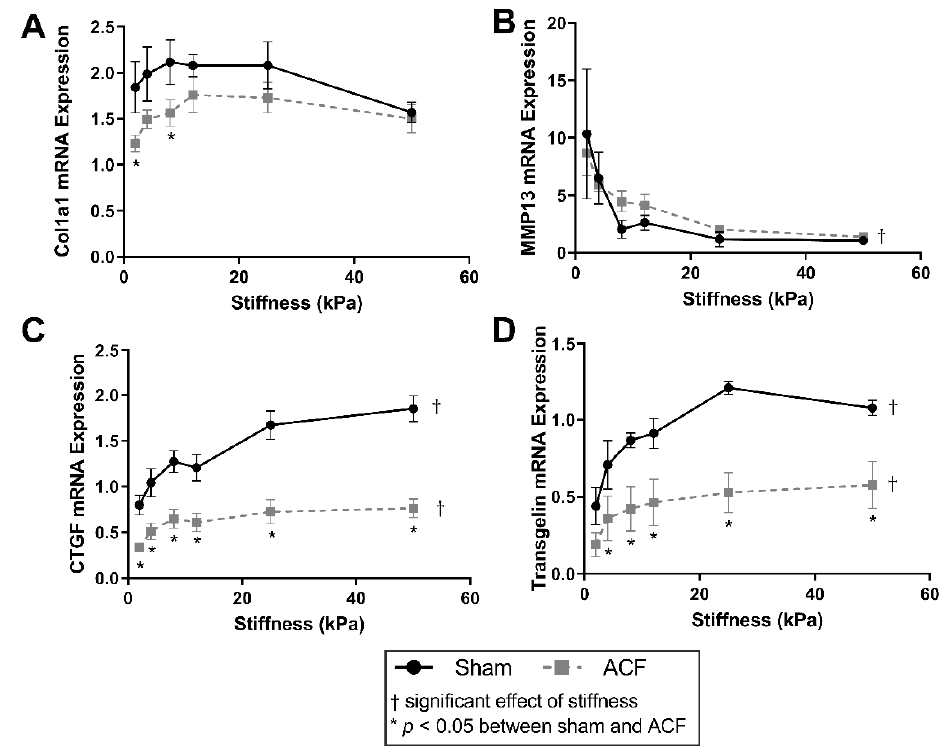
Figure 1. Soft substrates promote mRNA expression representative of a hypofibrotic phenotype. ( A ) Type-1 collagen mRNA expression is significantly different on softer substrates between sham and ACF. ( B ) MMP-13 mRNA expression decreases with increasing substrate stiffness in both sham and ACF CFs. ( C , D ) Relative mRNA expression of CTGF and transgelin follow a similar pattern, with relatively less in ACF compared to sham. * indicates p < 0.05 when comparing sham vs. ACF. † indicates a signi fi cant e ff ect of substrate sti ff